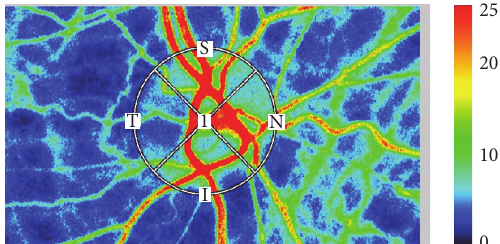
Figure 1: We used LSFG-NAVI to evaluate the ocular microcircula- tion, with three tests performed in each eye. We measured all MBR in the optic nerve head. In the color-coded maps, red indicates high blood flow and blue indicates low blood